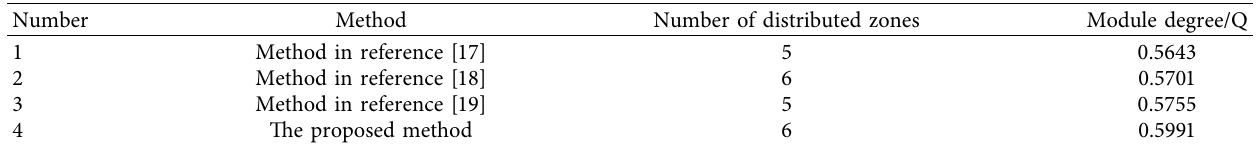
Table 4: Comparison of modularity of different